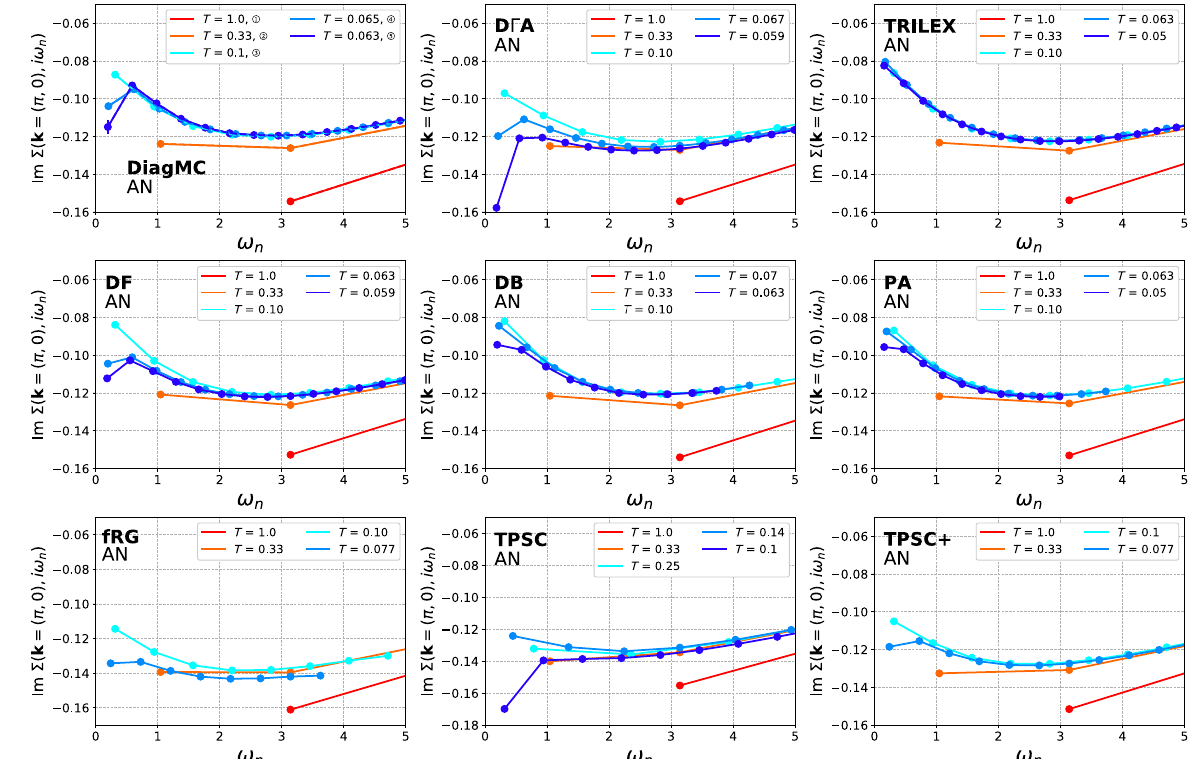
FIG. 10. Imaginary parts of the self-energies at the antinode as a function of Matsubara frequencies calculated by various many-body methods. Note that the lowest temperatures shown sometimes differ for the respective methods in order to show as many of the respective temperature regimes as possible. Also note that the vertical axis is different for the last row of three